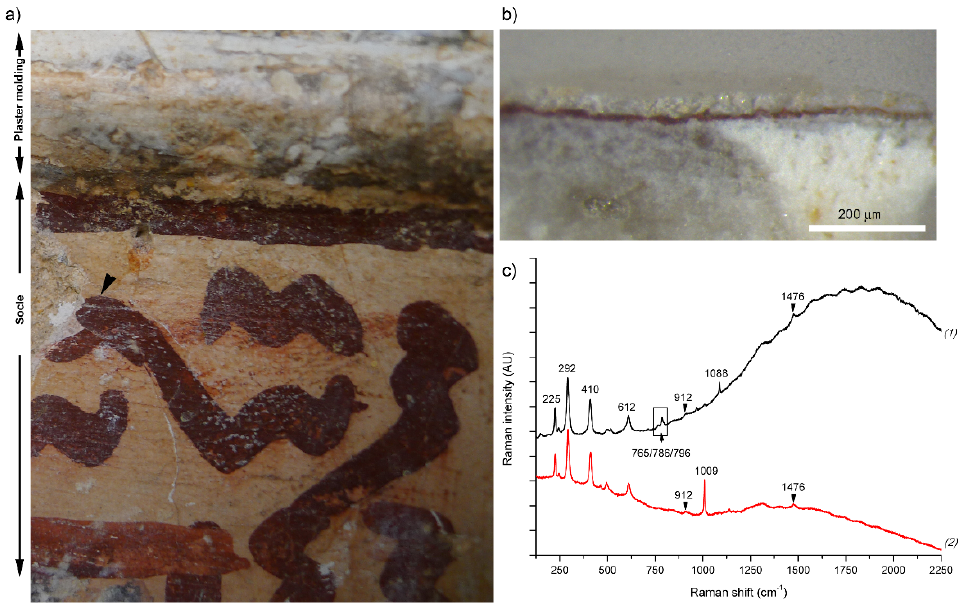
Figure 7. ( a ) Image showing the location where sample R was taken. ( b ) Optical microscopy image of sample R, focusing on the pictorial layer. ( c ) Raman spectra recorded (excitation 785 nm; objective 50 × ) on the pictorial layer of sample R: (1) internal part of the pictorial layer and (2) external part.